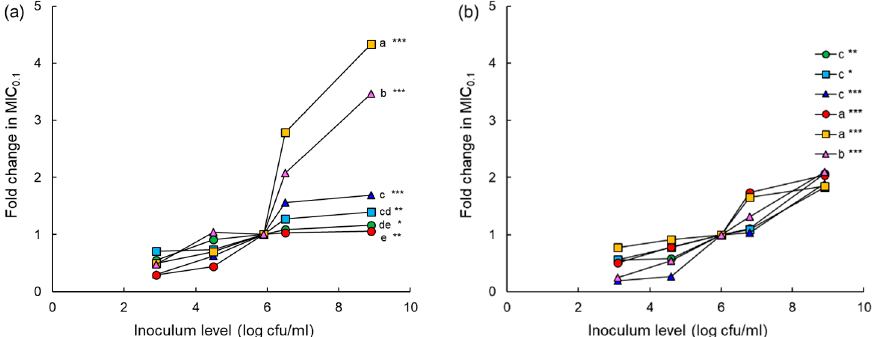
Figure 5. Inoculum effect of chloramphenicol (CHL; ● ), erythromycin (ERY; ■ ), tetracycline (TET; ▲ ), cephalothin (CEP; ● ), ciprofloxacin (CIP; ■ ), tobramycin (TOB; ▲ ) against different levels of antibiotic-sensitive Salmonella Typhimurium ATCC 19585 (ASST; ( a )) antibiotic-resistant S . Typhimurium CCARM 8009 (ARST; ( b )). Markers with different letters within an inoculum level (a–e) are significantly different among antibiotics at p < 0.05. *, **, and *** indicate significant difference between high (>6 log CFU/mL) and low (<5 log CFU/mL) inoculum levels at p < 0.05, p < 0.01, and p < 0.001, respectively.